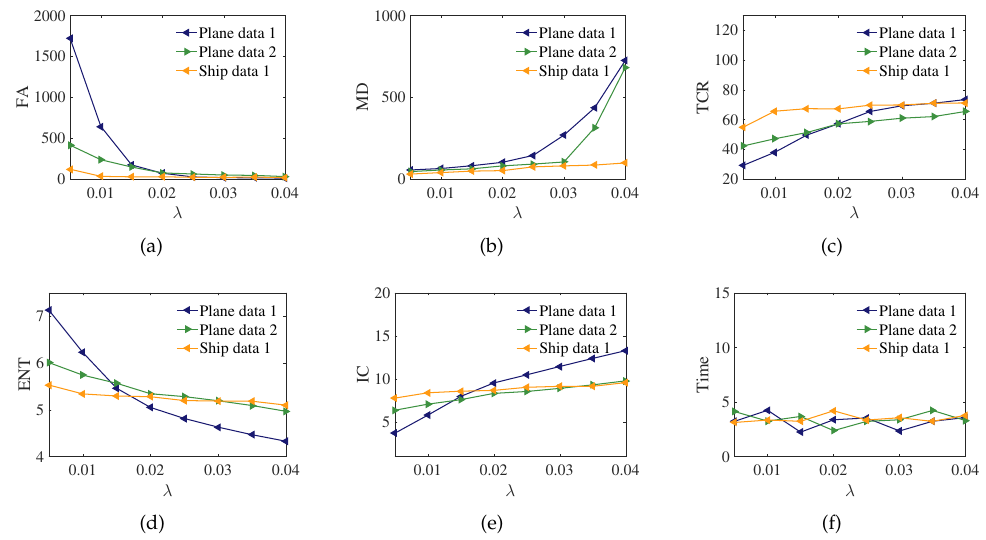
Figure 10. The curves showing the variation of the quantitative indices ( a ) FA, ( b ) MD, ( c ) TCR, ( d ) ENT, ( e ) IC and ( f ) time of imaging quality with different values of λ for three data sets.